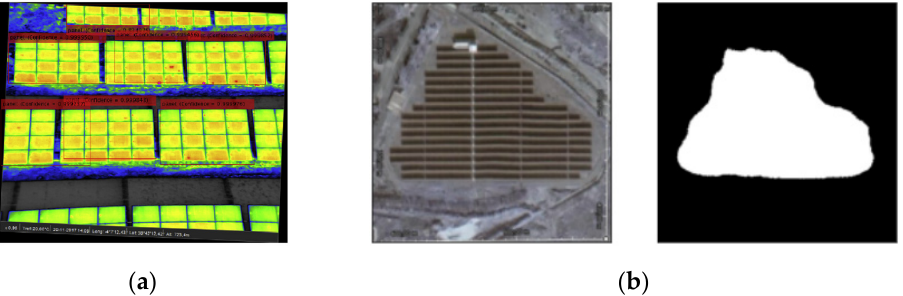
Figure 3. Examples of detection types for the detection of PV systems using aerial imagery: ( a ) boxes Reprinted with permission from ref. [61]. Copyright 2020 Copyright Elsevier; ( b ) mask [57].